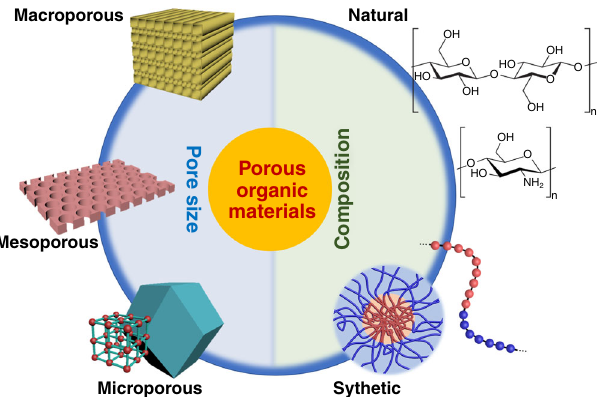
Fig. 1 Classi fi cations of porous organic materials based on pore size and composition. Porous organic materials can possess pores of different sizes including macropores, mesopores, and micropores. In terms of composition, the porous organic materials can be made of either natural or synthetic